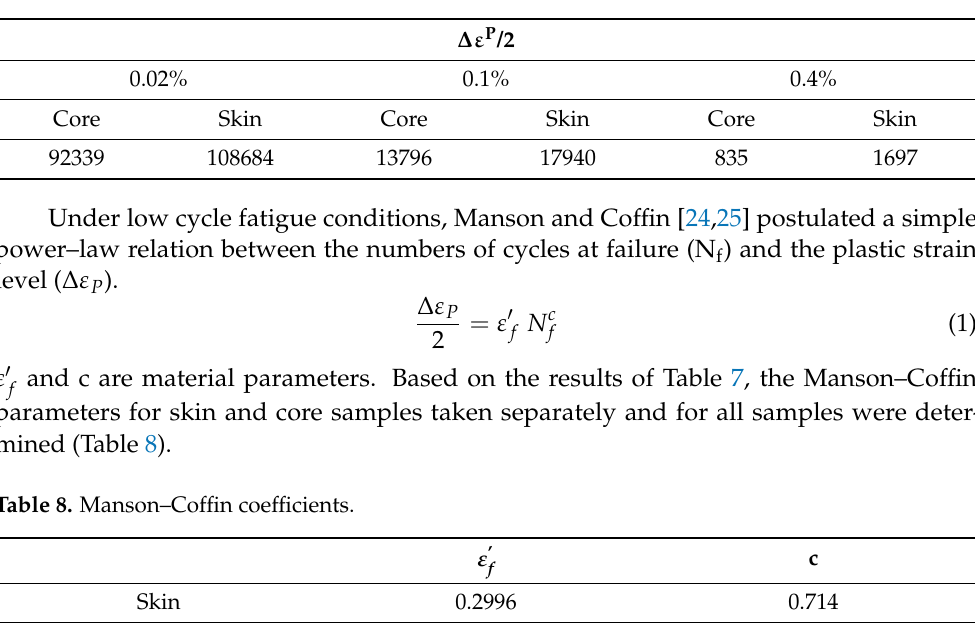
Table 7. Number of cycles at failure (Nf) as function of the plastic strain.